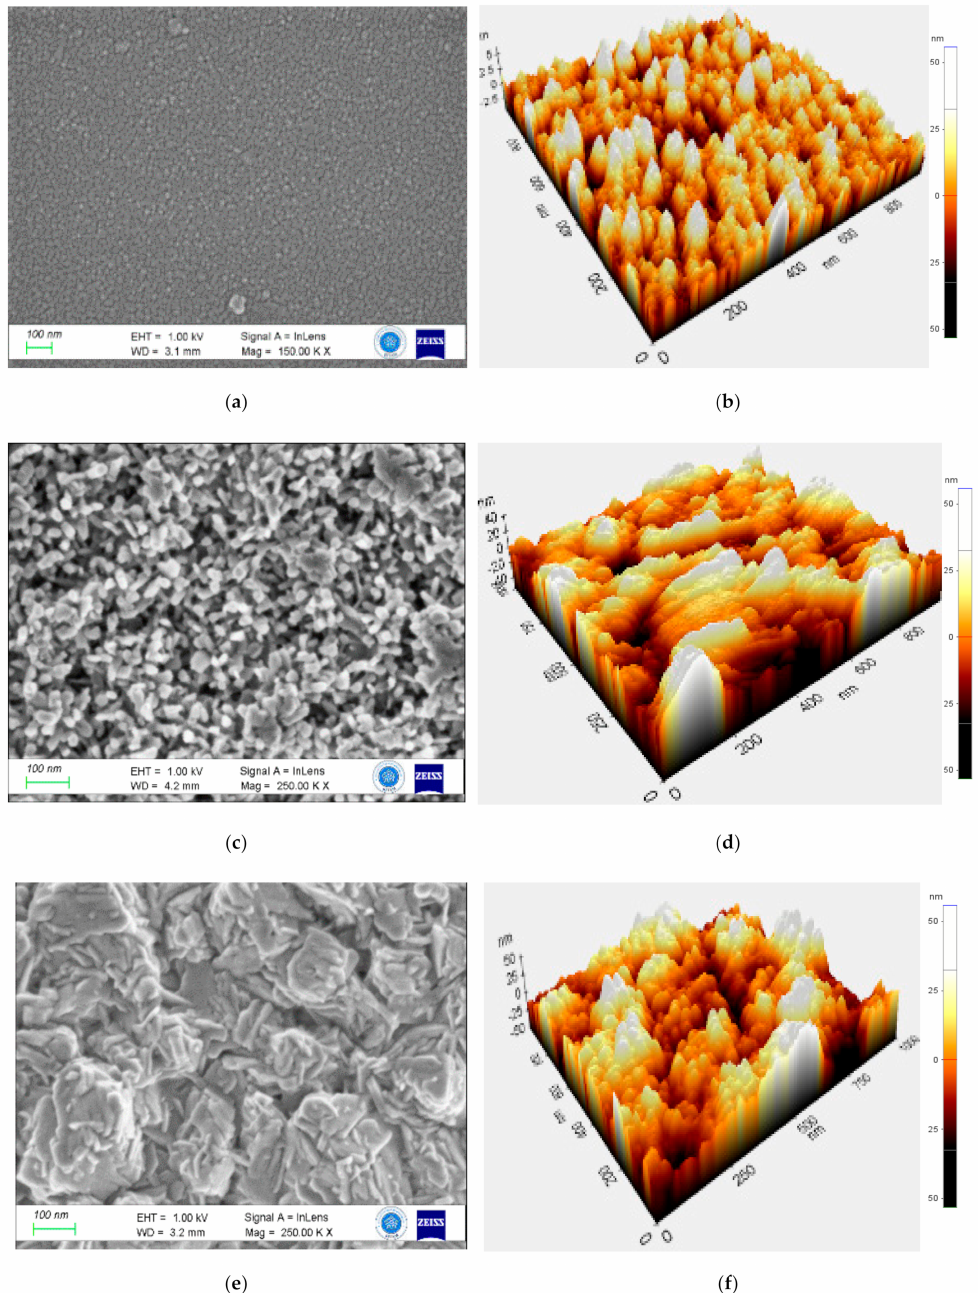
Figure 4. Morphological and topographical analysis of S1 ( a , b ), S2 ( c , d ), and S3 ( e , f ) samples,